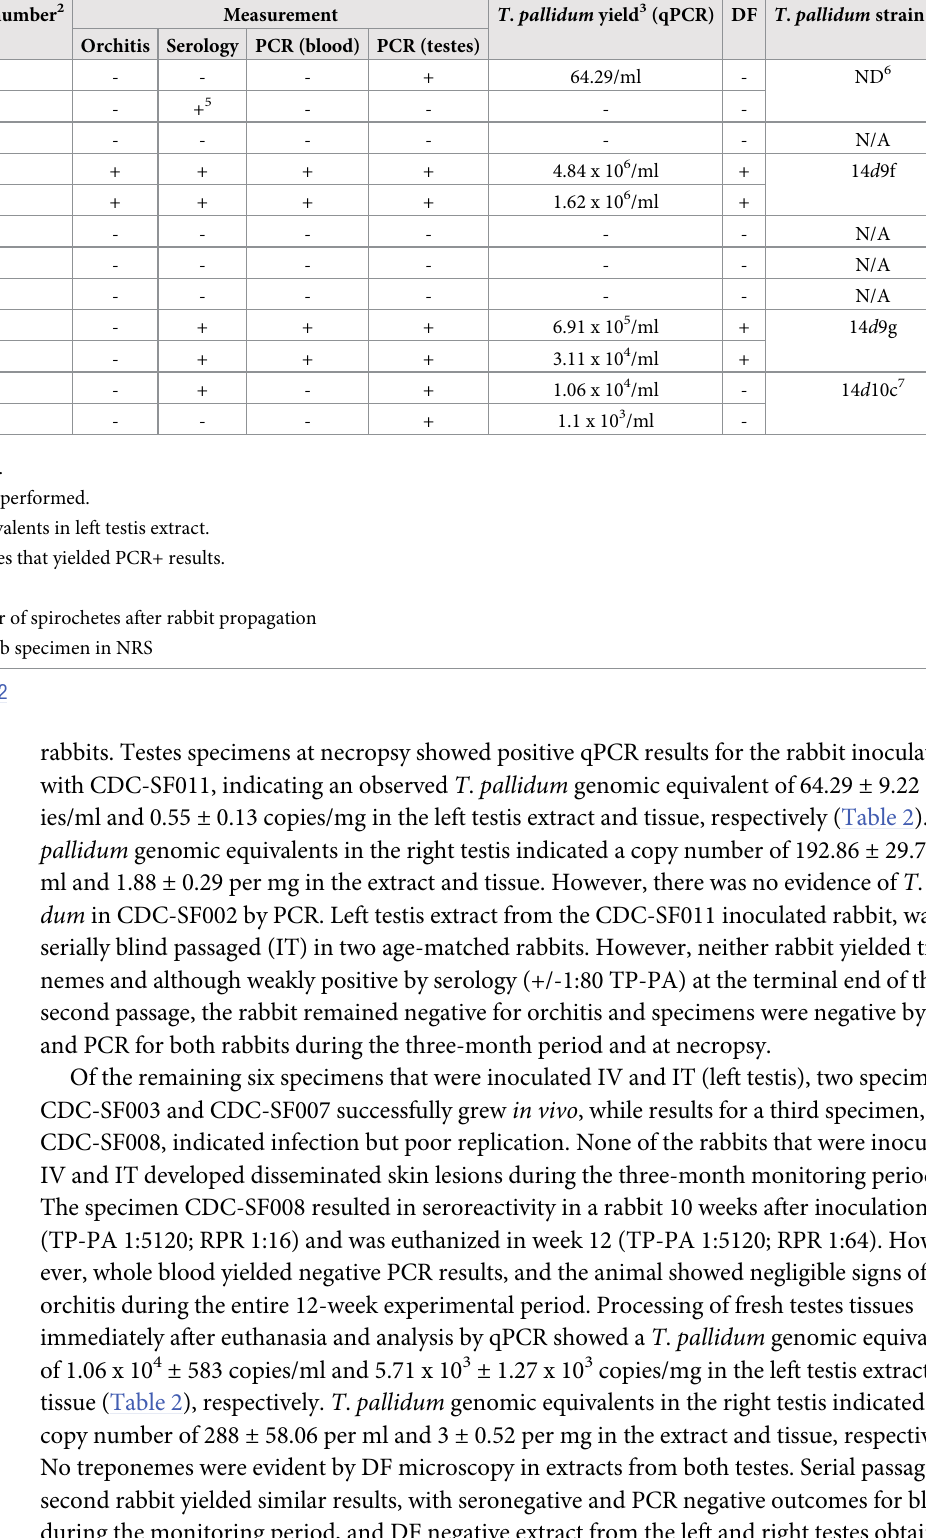
Table 2. Summary of end point measurements and T . pallidum yield where applicable for in vivo rabbit propagation of patient specimens. Specimen ID Inoculationroute 1 Passage number